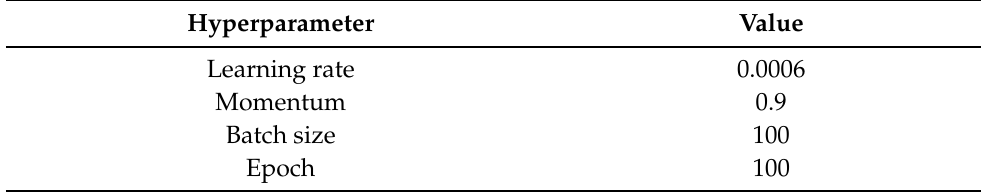
Table 1. The best baseline model hyperparameters.